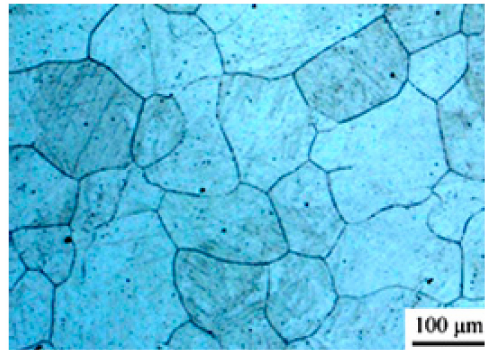
Figure 5. Initial grain size. Table 2. Partial prediction data of dynamic recrystallization grain